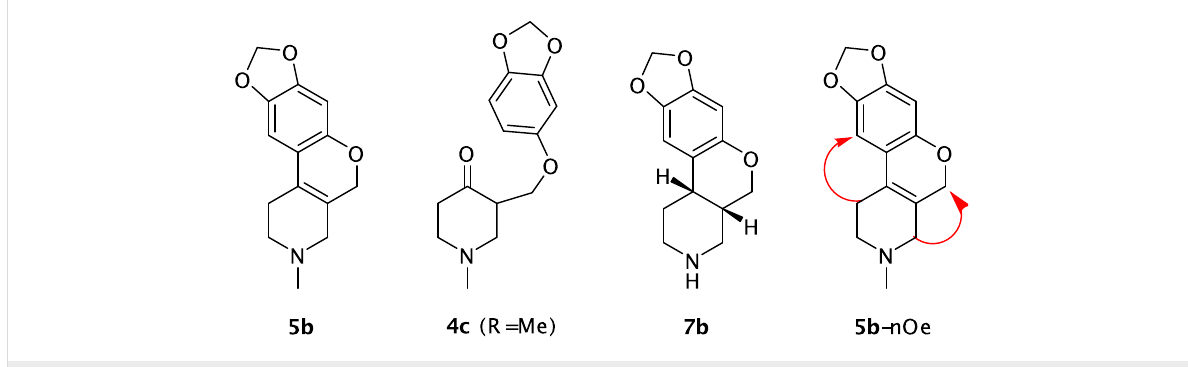
beyond 150 ppm in 13 C NMR indicated the absence of a